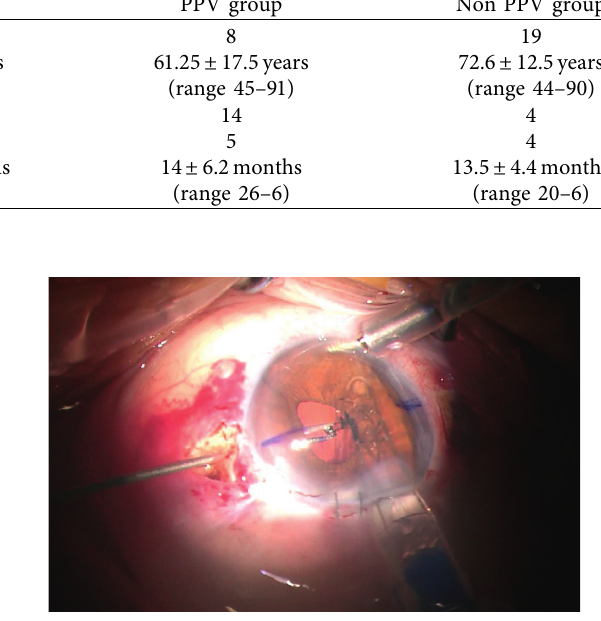
Figure 3: Leading plug grasped by crocodile tip